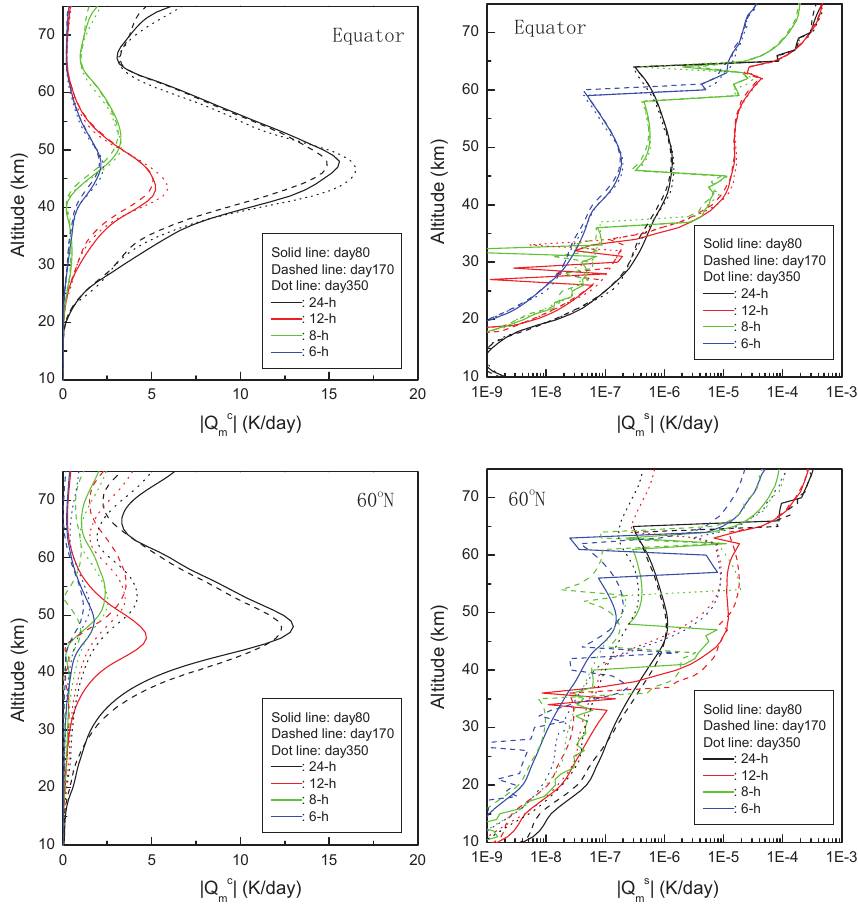
Fig. 1. Vertical profiles of the absolute values of the coefficients of the cosine (left) and sine (right) terms of the ozone heating rate tidal components for day 80, day 170, and day 350 in Figure 1 Vertical profiles of the absolute values of the coefficients of cosine term (left) and sine term (right) of ozone heating rate tidal components for day80, day170, and day350 in 2005.